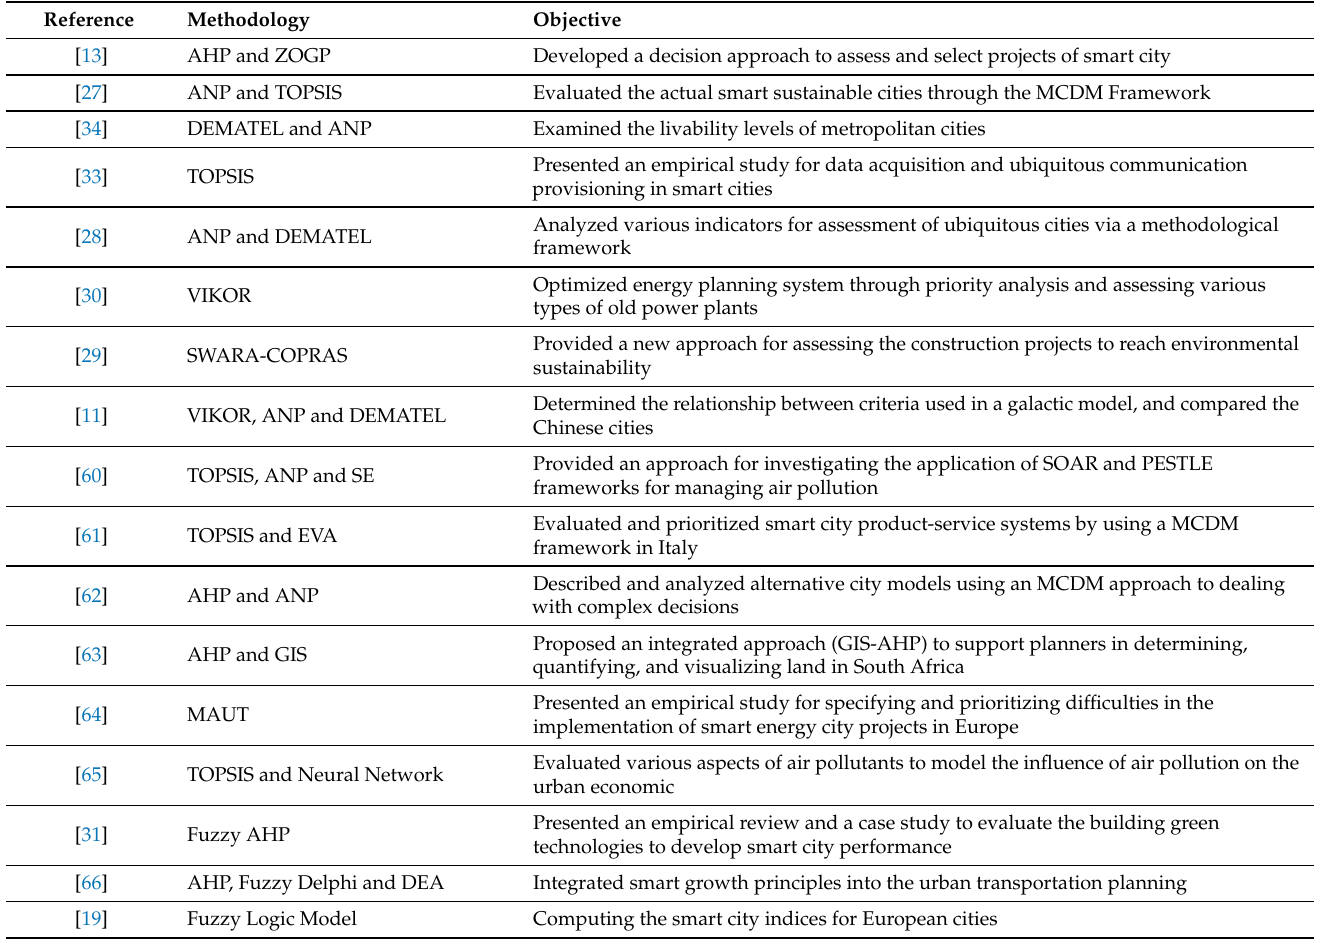
Table 1. A brief summary of discussed works on smart city